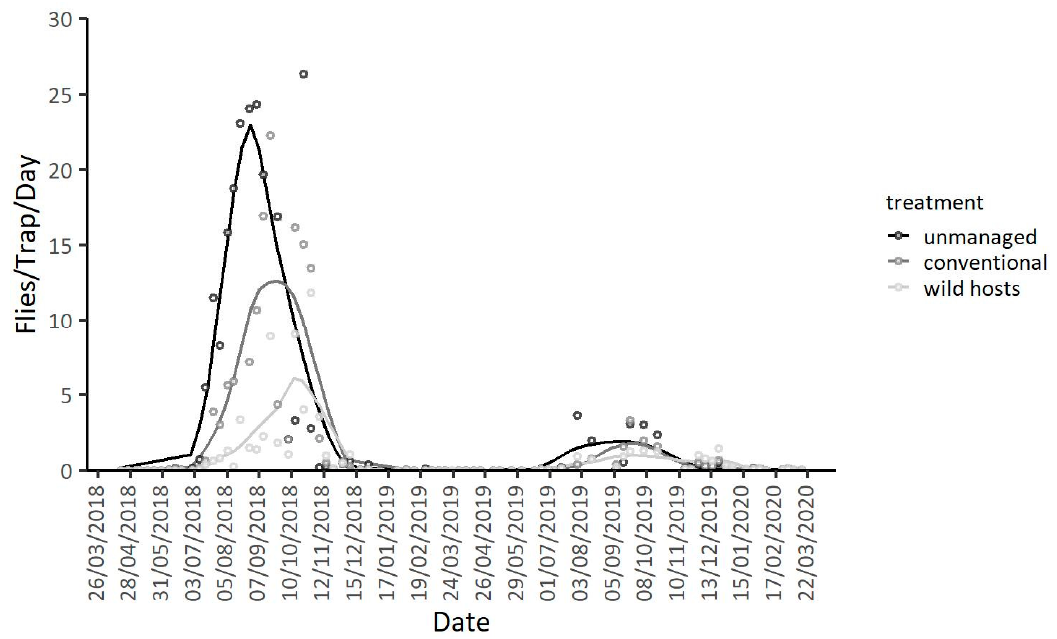
Figure 6. Adult captures per trap per day and smoothed LOESS curves for unmanaged, conventional cherry trees, and wild vegetation in Agia Fotini from 26 March 2018 to 22 March 2020.